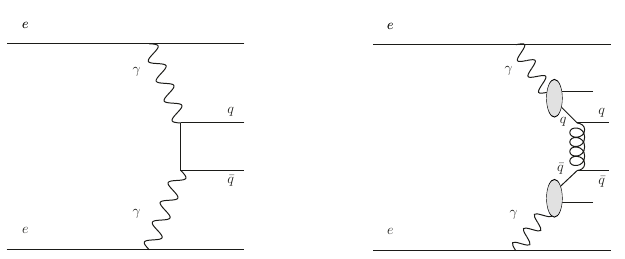
Figure 1 . Diagrams for example of direct(left) and resolved(right) photoproduction processes at e + e − collider. The diagrams are drawn by JaxoDraw